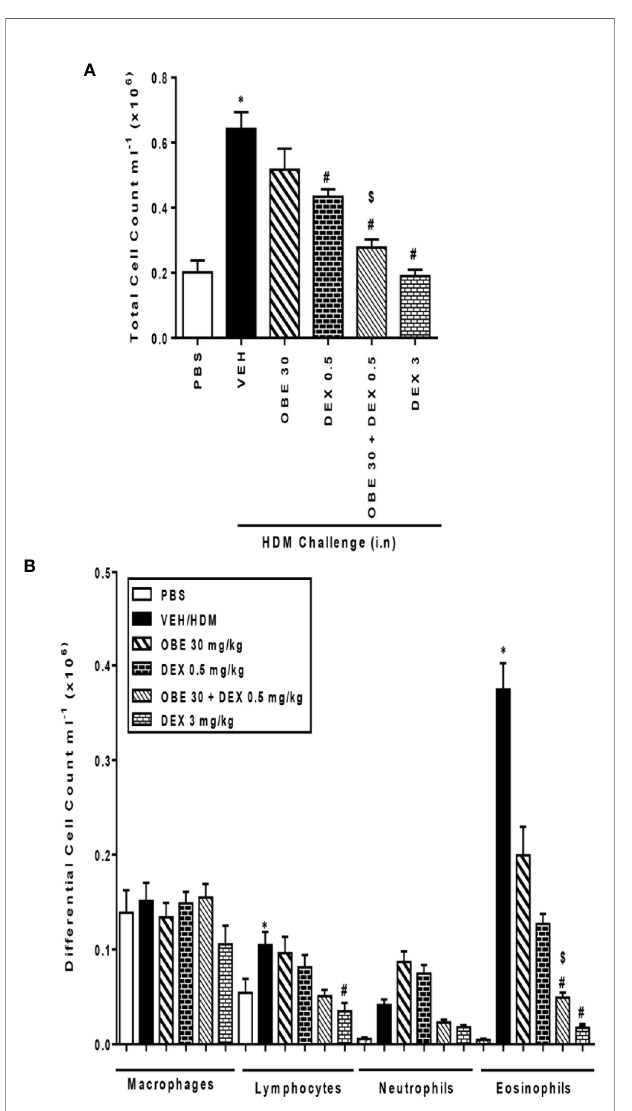
FIGURE 9 | Effect of OBE (30 mg/kg; i.p.) both alone and in combination with low dexamethasone (0.5 mg/kg) on HDM-induced increase in (A) total cell and (B) differential cell count. Treatment with OBE, in combination with low dose dexamethasone, resulted in a signi fi cant inhibition of both total and eosinophil numbers compared to either treatment alone. Data are expressed as mean ± SEM ( n = 7 – 11). *P < 0.05 vs PBS group, # P < 0.05 vs HDM group and $ P < 0.05 versus either OBE (30 mg/kg; i.p.) alone or dexamethasone (0.5 mg/kg/i.p.) alone.